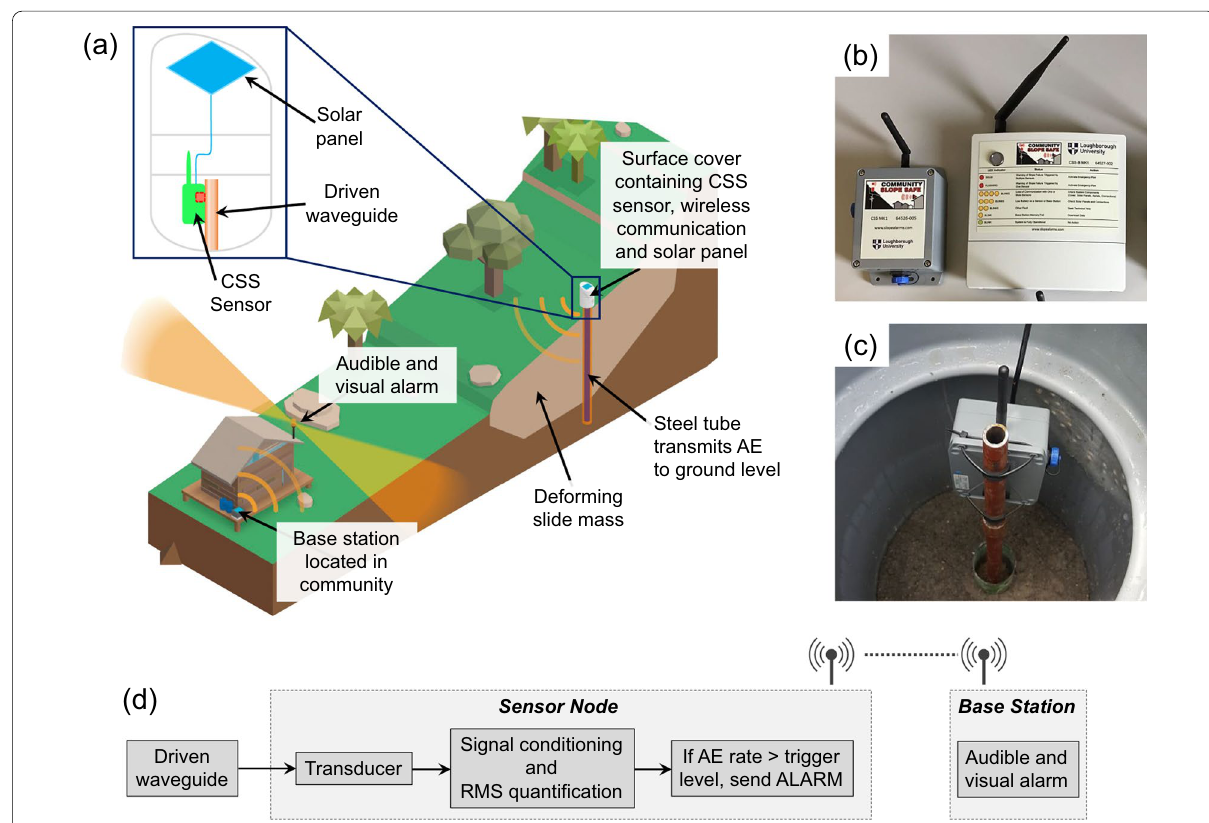
Fig. 2 a Community Slope SAFE (CSS) AE monitoring approach incorporating a driven waveguide, b CSS sensor and base station components, c a view of a sensor located on the waveguide inside a cover, and d system architecture of the Community Slope SAFE approach (modified after Dixon et al.